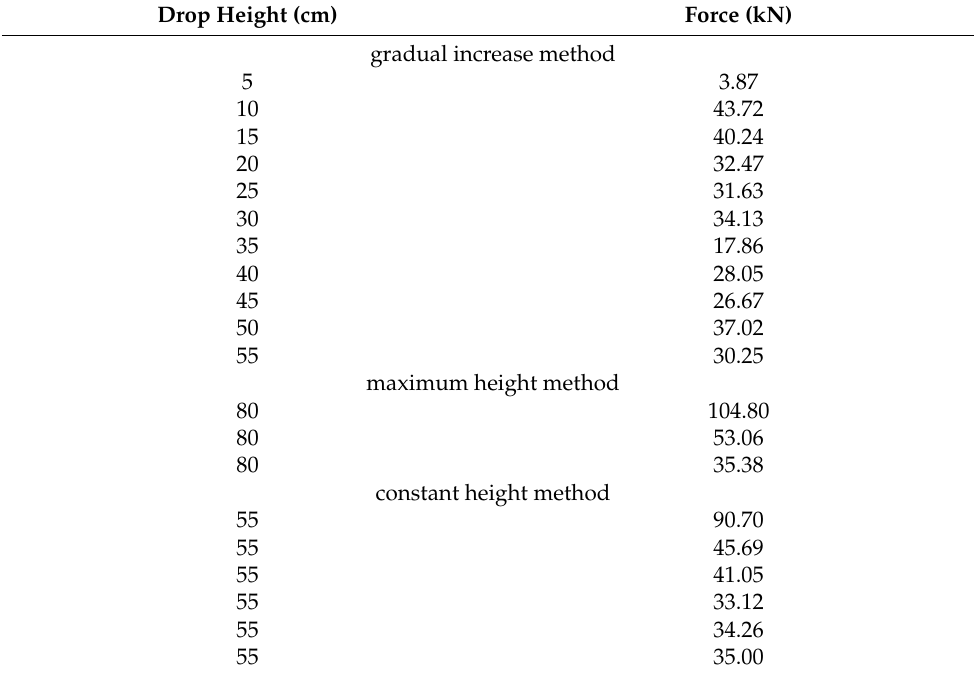
Figure 9. Results of reinforced concrete — ( a ) gradual increase method, ( b ) maximum height method, ( c ) constant height method . ( c ) constant height method. Table 5. Data from reinforced concrete testing. Drop Height